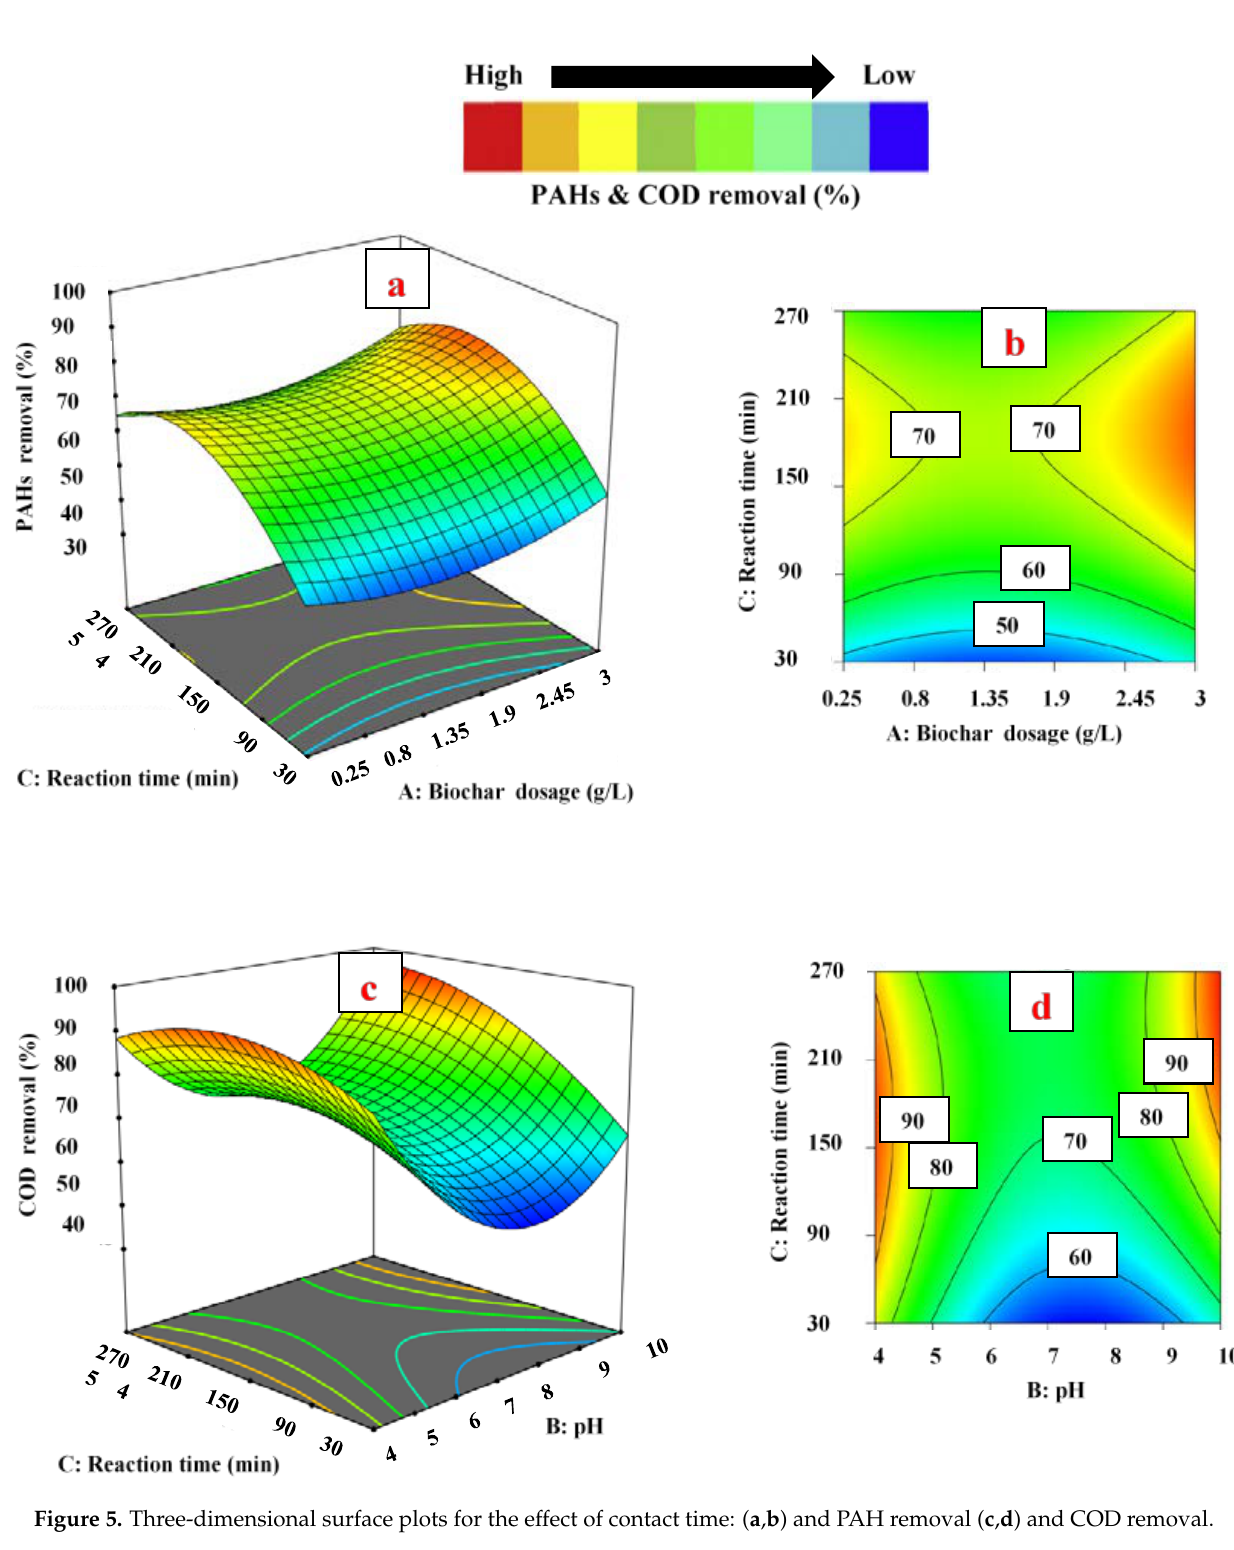
Figure 5. Three-dimensional surface plots for the effect of contact time: ( a ) and ( b ) PAH removal ( c ) and ( d ) COD removal.